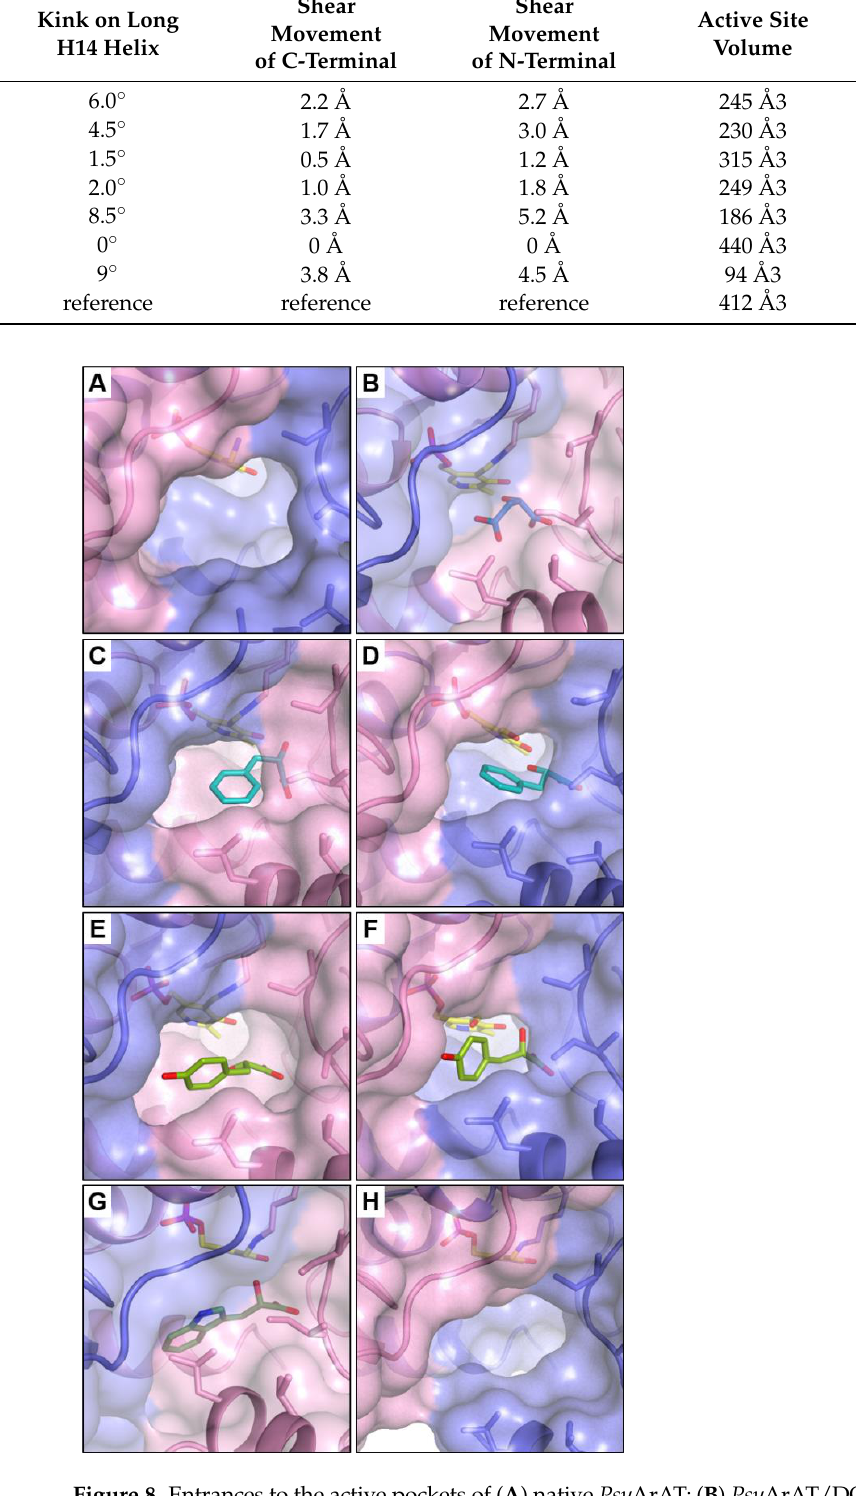
Figure 8. Entrances to the active pockets of ( A ) native Psy ArAT; ( B ) Psy ArAT/DOH; ( C , D ) Psy ArAT/FOH in A and B monomers; ( E , F ) Psy ArAT/YOH in A and B monomers; ( G , H ) Psy ArAT/WOH in A and B monomers.